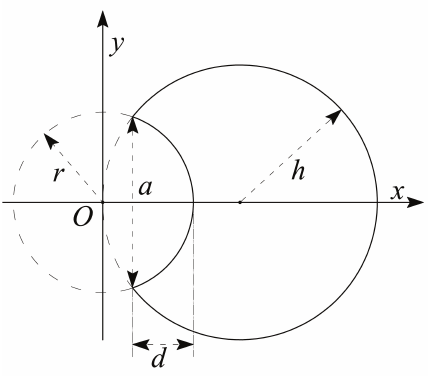
Figure 6. Reference frame, cross-section with radius h , and notch with radius r